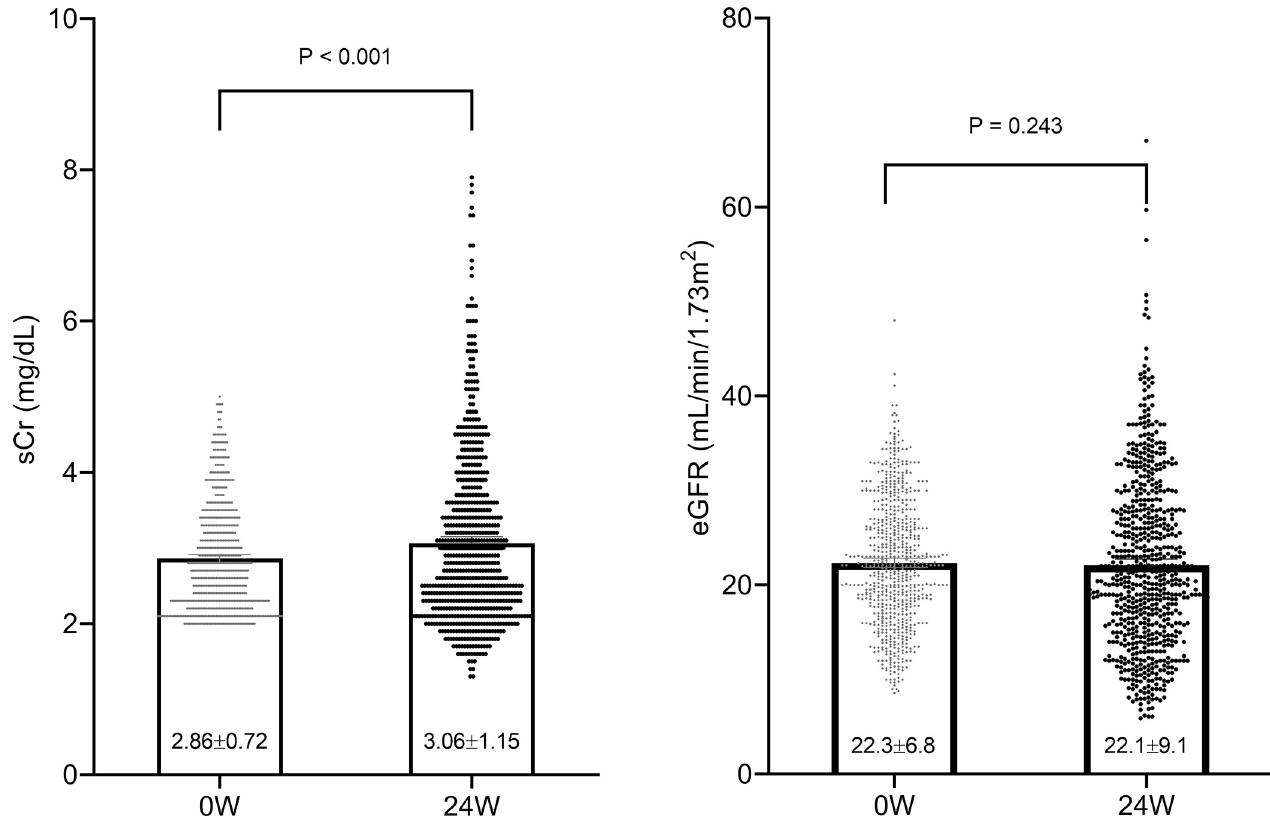
Fig 2. Change in serum creatinine and eGFR after 24 weeks of treatment. (A) Serum creatinine was significantly increased after treatment with Renamezin 1 (2.86 ± 0.72 and 3.06 ± 1.15 mg/dL, p < 0.001). (B) The eGFR did not significantly change after treatment (22.3 ± 6.8 and 22.1 ± 9.1 mL/min.1.73 2 , p = 0.243).